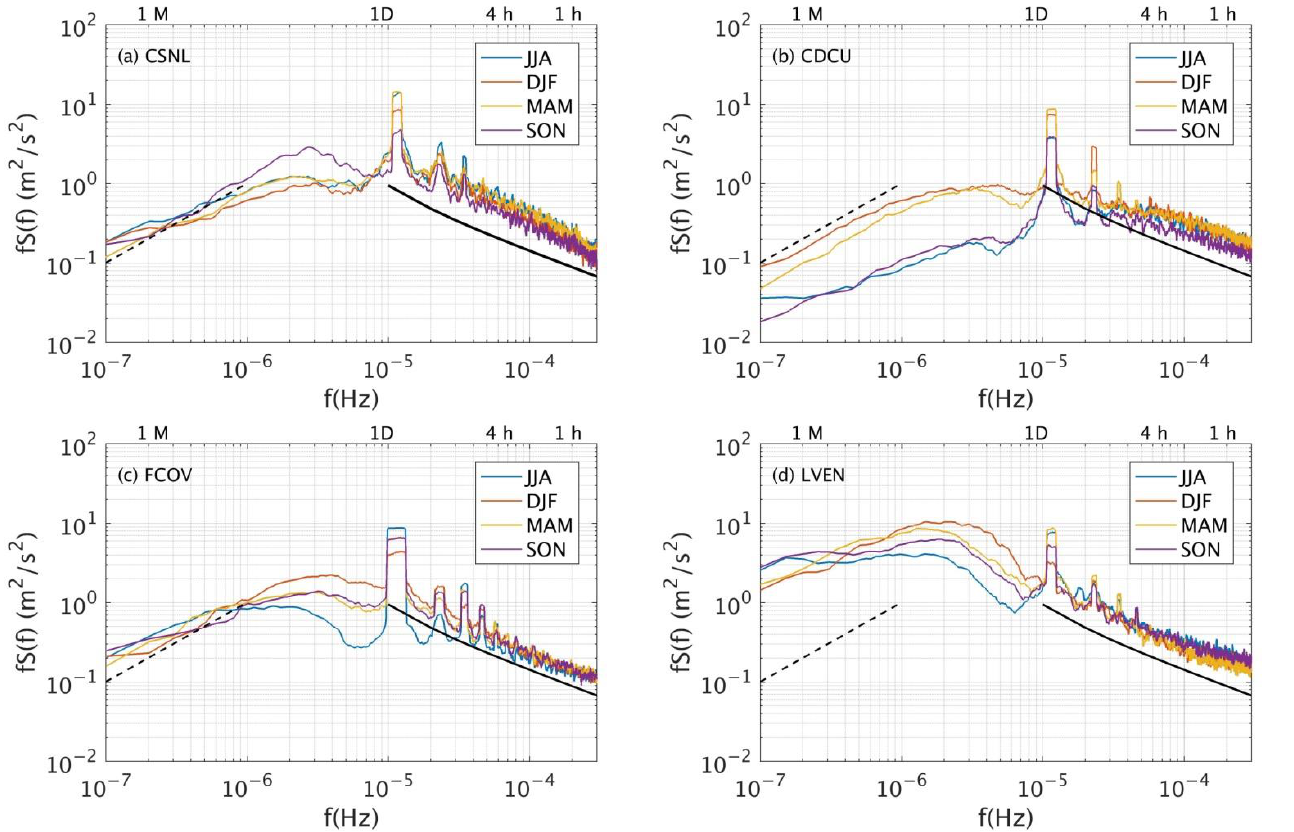
Figure 2. Seasonal smoothed frequency-weighted spectra fS(f) of horizontal wind speed for ( a ) Cabo San Lucas (CSNL), ( b ) Ciudad Cuauhtemoc (CDCU), ( c ) Francisco Villa (FCOV), ( d ) La Venta (LVEN). The solid black line corresponds to the slope f − 2/3 . The dotted black line represents the f +1 slope. JJA: June – July – August (blue line); DJF: December – January – February (orange line); MAM: March – April – May (yellow line); SON: September – October – November (purple line).